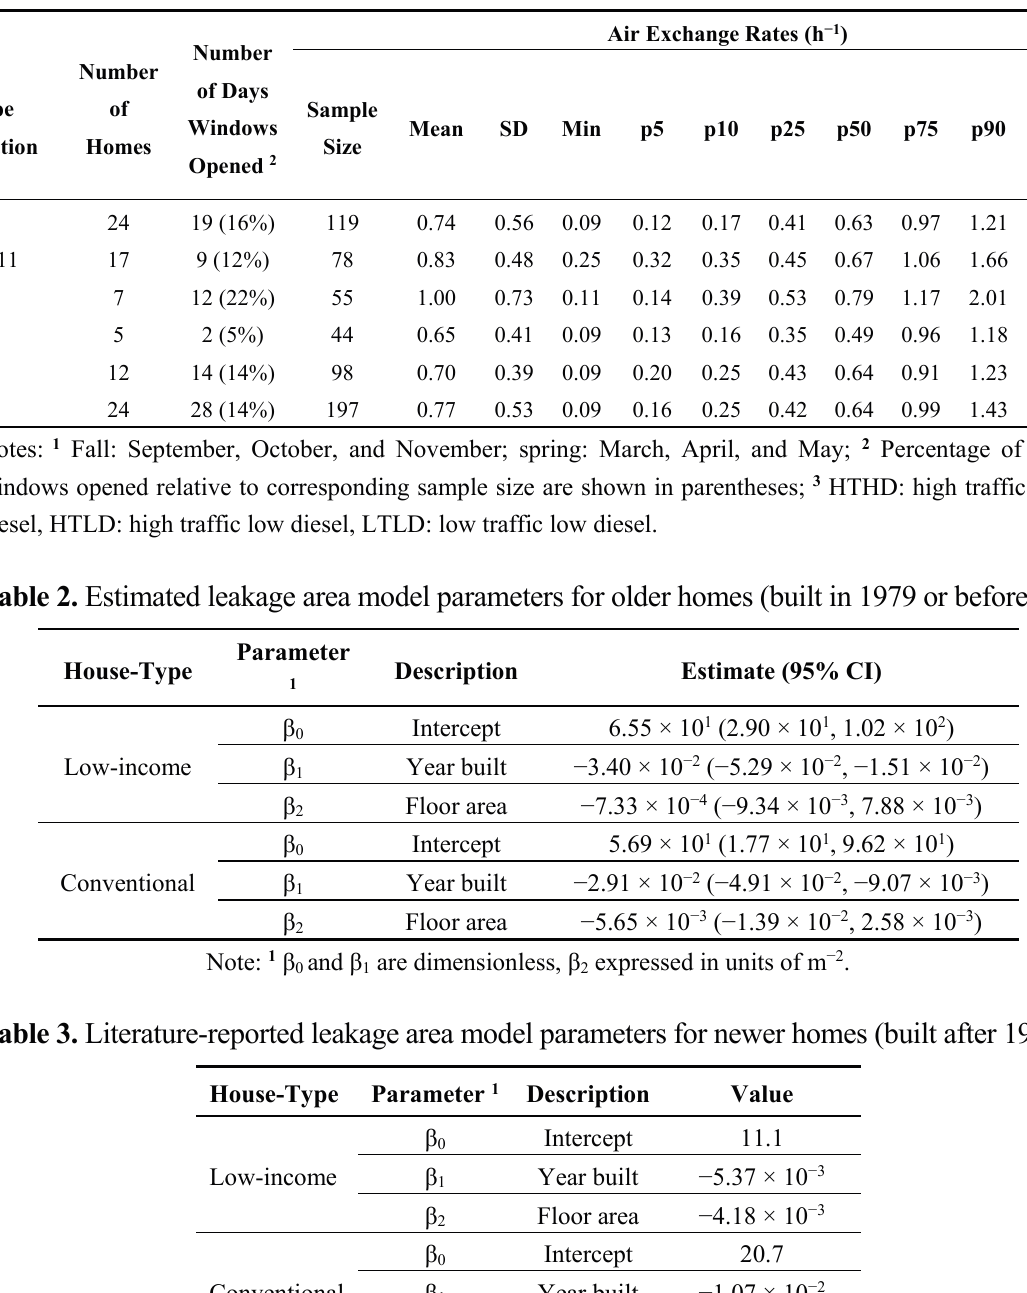
Table 1. Number of homes, number of days windows opened, and summary statistics for measured 24 h average air exchange rates.